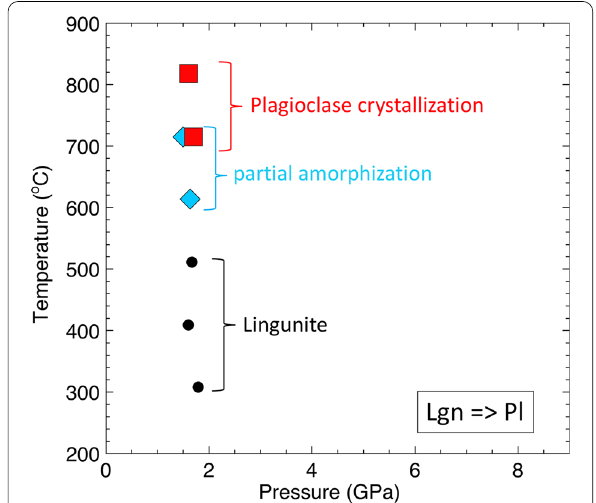
Fig. 8 P–T conditions for the back-transformation in lingunite. Partial amorphization and plagioclase crystallization proceeded with increasing temperatures (Run